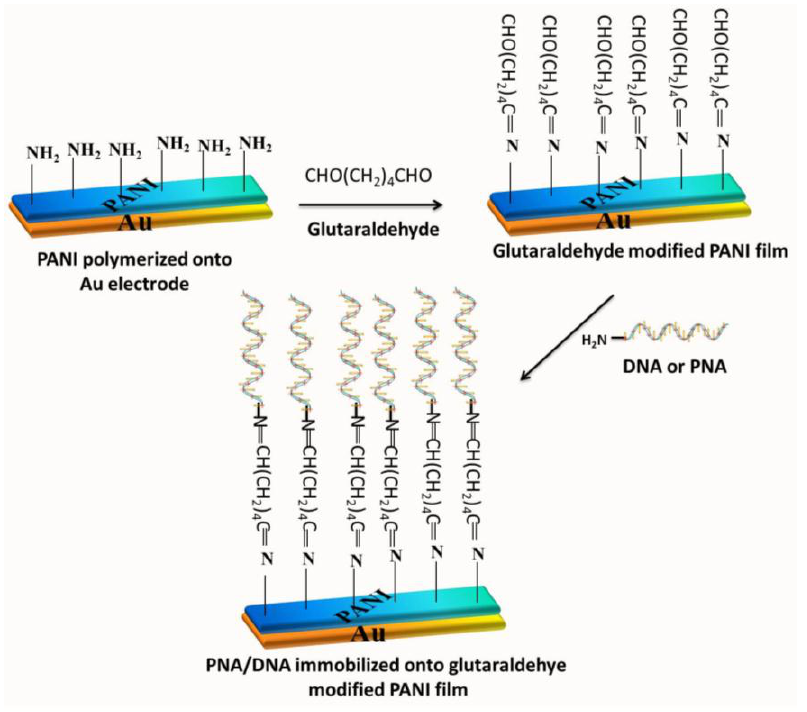
Figure 5. NH 2 -DNA and peptide nucleic acid (PNA) immobilization on polyaniline-coated gold film. (Redrawn with permission from [174]. Copyright 2014, American Chemical